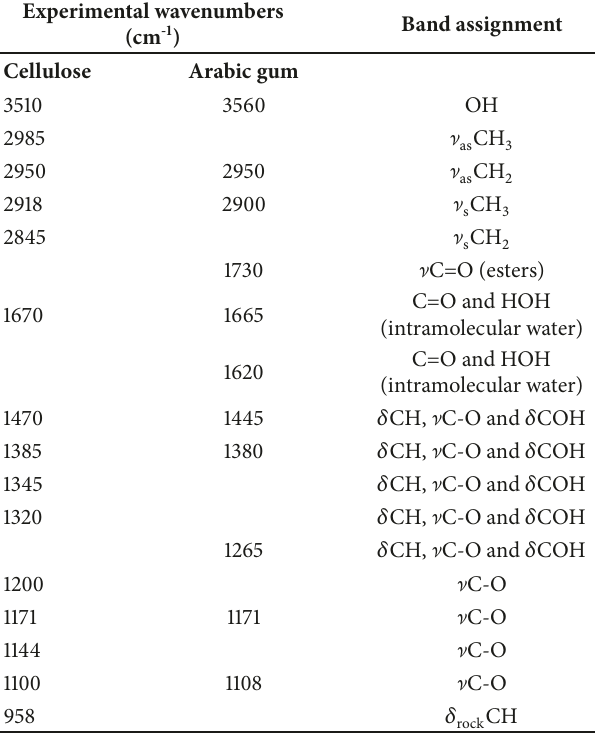
Table 3: Experimental wavenumber values corresponding to the maximaof themid-IR totalreflectionmodebands of polysaccharide materials and their tentative assignment.